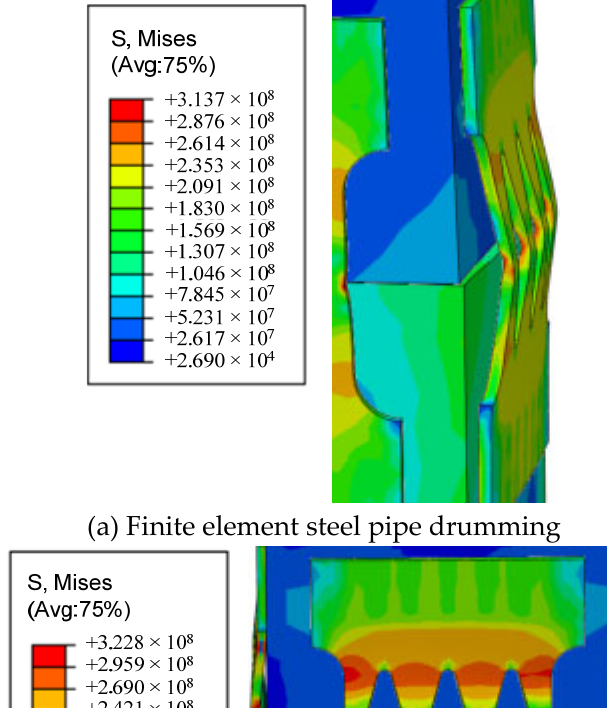
Figure 8. Diagram of the mechanical behavior of simulation results and test results.